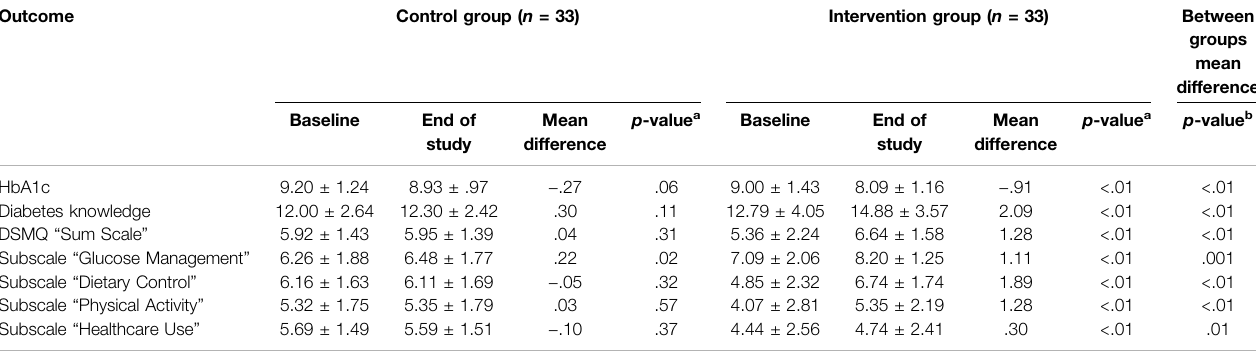
TABLE 2 | Comparison of participants ’ scores in glycemic control and other health-related clinical outcomes in both groups at baseline and at 6 month ’ s follow up. Outcome